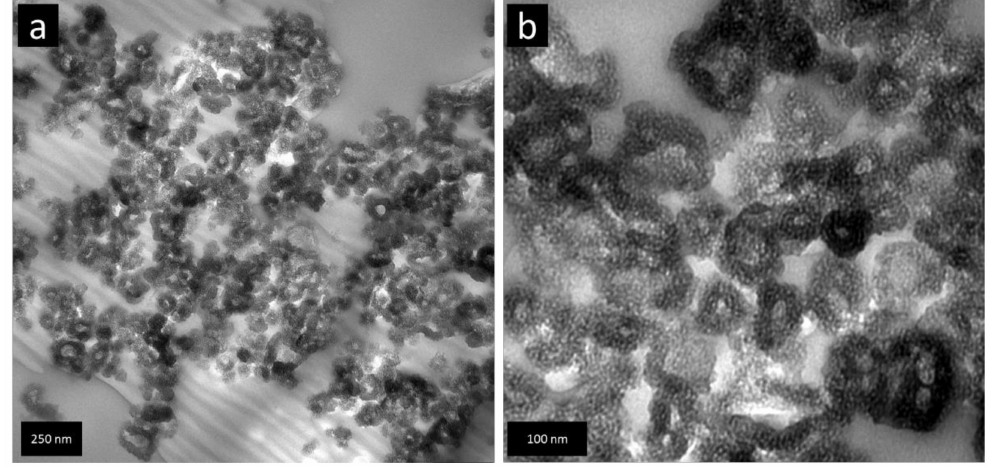
Figure 2. TEM images of sample BPO-C at low ( a ) and high ( b )